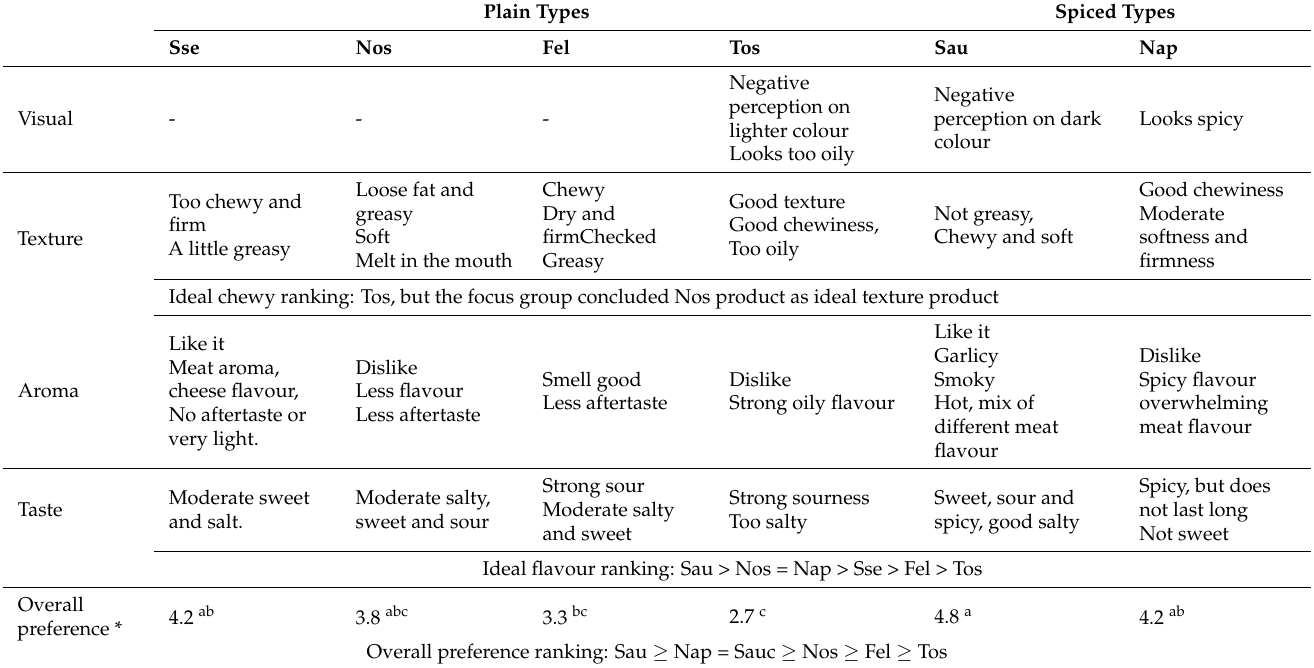
Table 2. Summary of comments from a Chinese focus group regarding six commercial fermented meat products of either plain or spiced